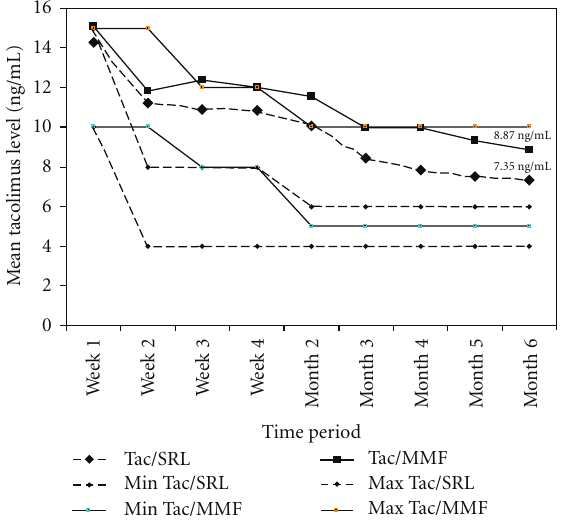
Figure 2: Data presented are for the FAS population. Mean tacrolimus trough levels in the Tac/SRL group were higher than the recommended upper level throughout the study. In the Tac/MMF group, mean trough levels were within the recommended ranges from month 3